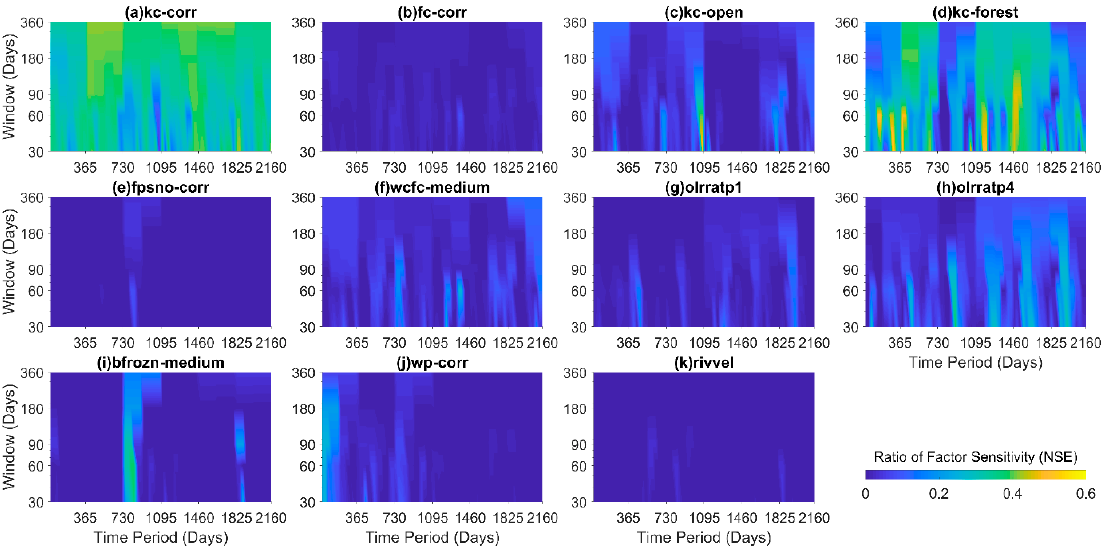
Figure 8. Ratio of factor sensitivity for moving windows of 30 days, 60 days, 90 days, 180 days and